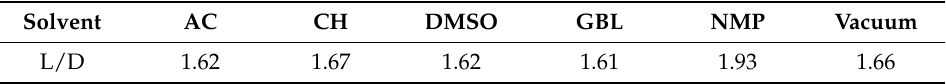
Figure 3. The growth morphology of RDX in solvents including acetone ( a ); cyclohexanone ( b ); γ -butyrrolacton ( c ); dimethyl sulfoxide ( d ); and N -methyl-2-pyrrolidone ( e ); vacuum ( f ) respectively. Table 4. Calculated length/diameter ratio of RDX crystal.